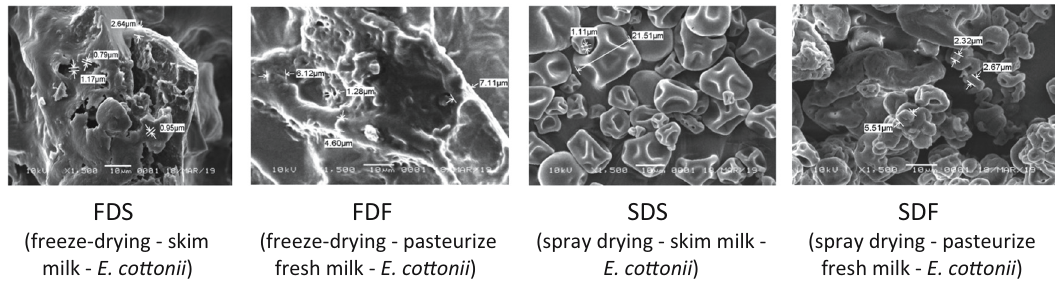
Figure 1: Hydrated L. acidophilus morphology structure. ( a ) FDS ( freeze - drying – skim milk – E. cottonii ) , ( b ) FDF ( freeze - drying – pasteurized